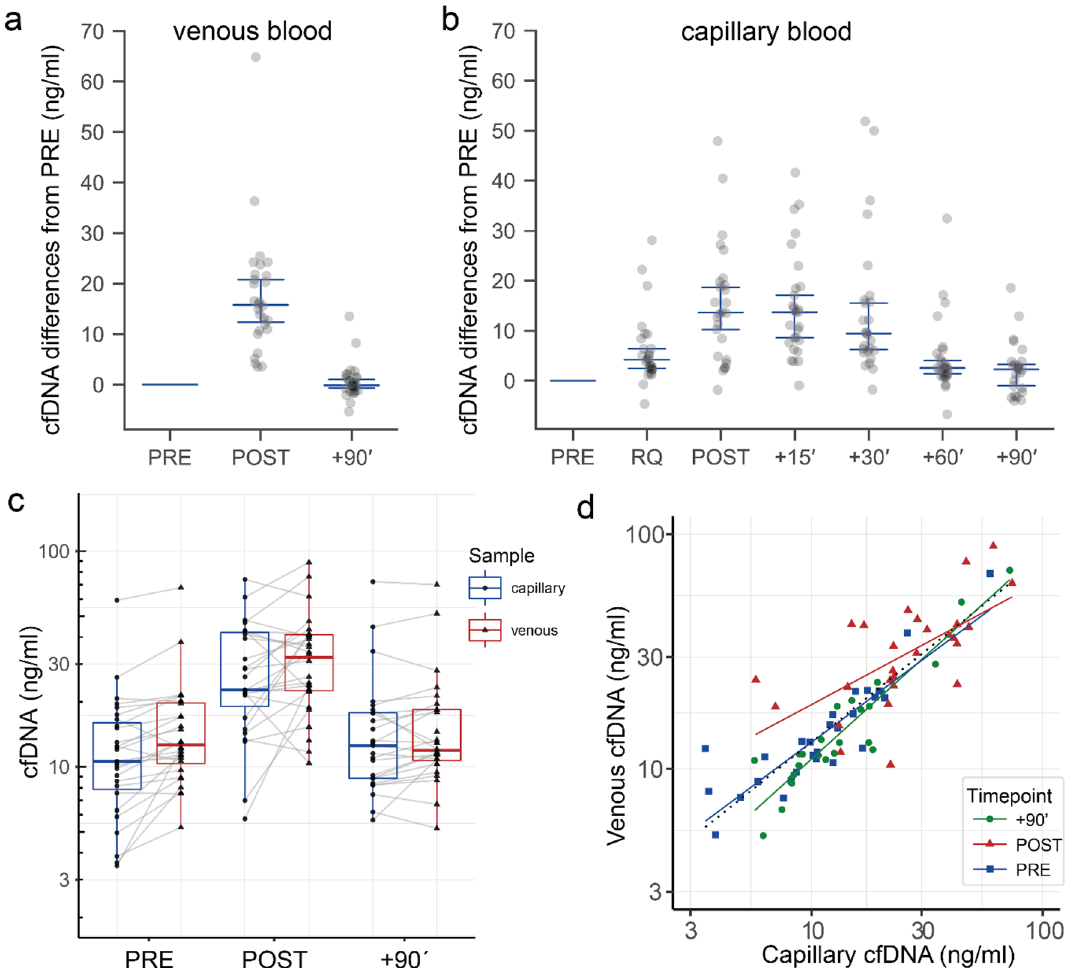
Figure 4. Kinetics of venous and capillary cfDNA measured with the L1PA2_90bp assay before and after exercise. Differences of cfDNA from PRE samples during and after exercise in venous plasma samples ( a ) and capillary plasma samples ( b ) (median and 95% CI are illustrated). ( c ) Boxplots of cfDNA concentration in capillary and venous plasma samples. ( d ) Correlation between venous and capillary cfDNA concentrations. The figures ( a , b ) were produced using the Python (v3.7.6) 28 libraries matplotlib (v3.1.1) 29 , and seaborn (v0.9.0) 30 . Figures ( c , d ) using R (v3.6.3) 31 package ggplot2 (v3.3.2) 36 not measurable. The estimated means of the SLE patients’ venous cfDNA levels increased significantly ~ 2.1 fold from 13.9 ng/ml (95% CI 10.4–18.8) to 29.6 ng/ml (95% CI 22.0–39.9) and decreased to 14.1 ng/ml (95% CI 10.5–19.9) 90 min after walking exercise (Fig. 4c). Similarly, the capillary samples increased significantly ~ 2.2 fold from 11.1 ng/ml (95% CI 8.0–15.4) to 24.8 ng/ml (95% CI 17.9–34.4) and decreased to 13.6 ng/ml (95%CI 10.0–18.4). After 90 min the concentrations declined to PRE exercise values again. A detailed results table for the multiple comparisons is given in Supplementary Table S5 and S6. Figure 4a and 4b display the differences of cfDNA levels from the PRE value. A comparison between patients receiving medication and non-medicated patients did not reveal significant differences of resting cfDNA concentrations ( p = 0.28) and corresponding fragmentation indexes ( p = 0.21). The comparison between venous and capillary cfDNA concentrations (Fig. 4d) shows an overall correlation of R 2 = 0.774, p < 0.0001 (dotted black line). The correlation between venous and capillary samples is higher for the PRE exercise ( R 2 = 0.933, p < 0.0001), and + 90 min samples ( R 2 = 0.974, p < 0.0001) compared to POST exercise samples (ρ = 0.726, p = 0.0002). As indicated in Fig. 5a, cfDNA remains increased until 30 min post exercise. The linear regression across all time points (black line) indicates a half-life of ~ 30 min (slope = − 0.167, intercept = 16.87). Between 30 min post exercise and 60 min post exercise the cfDNA concentrations show the highest decay rate. The linear regres- sion between + 30 and + 60 min indicates a half-life of about ~ 15 min (red regression line, slope = − 0.315, intercept = 23.61). The fragmentation index, calculated as the quotient of the concentrations of the longer L1PA2_222bp fragments and the shorter L1PA2_90bp fragments, increases from 0.33 ± 0.23 ng/ml at the PRE time point to 0.35 ± 0.23 ng/ml post exercise, and decreases to 0.32 ± 0.26 ng/ml after 90 min (Fig. 5b).